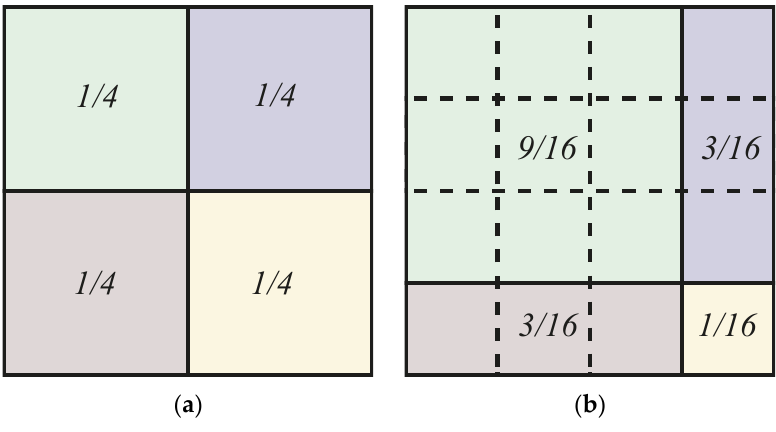
, 𝑝 2 = 1 , since ∏ 𝑝̃ 𝑖𝑀 = 𝑝̃ 1 𝑝̃ 2 = 1 2 2